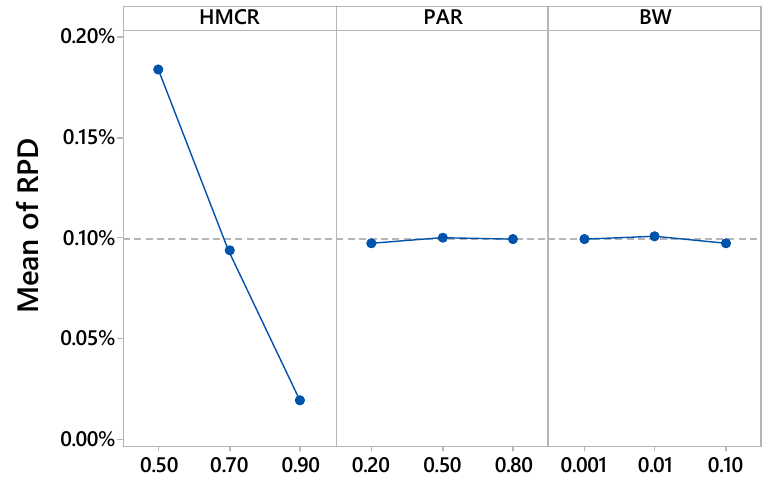
Figure 1. Main effects plot for the calibration of the hybrid Harmony Search.